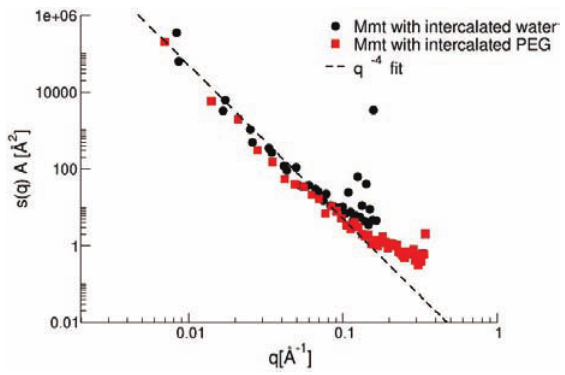
Fig. 5 – Spectral intensity per undulatory mode versus wave-vector in the x and y directions for MMT intercalated with water (1055000 atoms) and 3978 g mol –1 PEG (1756020 atoms) in the x and y di- rections. The dashed line is a fit to the undulatory q − 4 modes for q < 0 . 04 with k = 1 . 7 × 10 − 17 J. The local peak centred on q = 0 . 35Å − 1 and 0.175Å − 1 is due to artificial periodicity resulting from the way isomorphic substitutions are included in all the mod- els. Isomorphic substitutions in real clays are randomly distributed so this peak can be